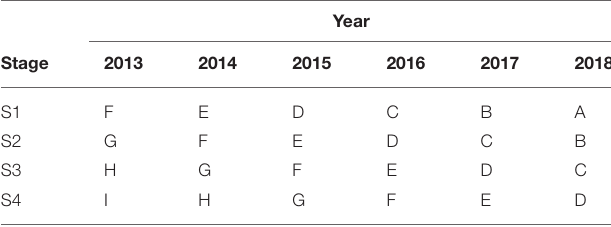
TABLE 2 | Data bands for potential inclusion in a MET dataset for selection decisions in 2018 from a breeding program with four stages of selection (S1 to